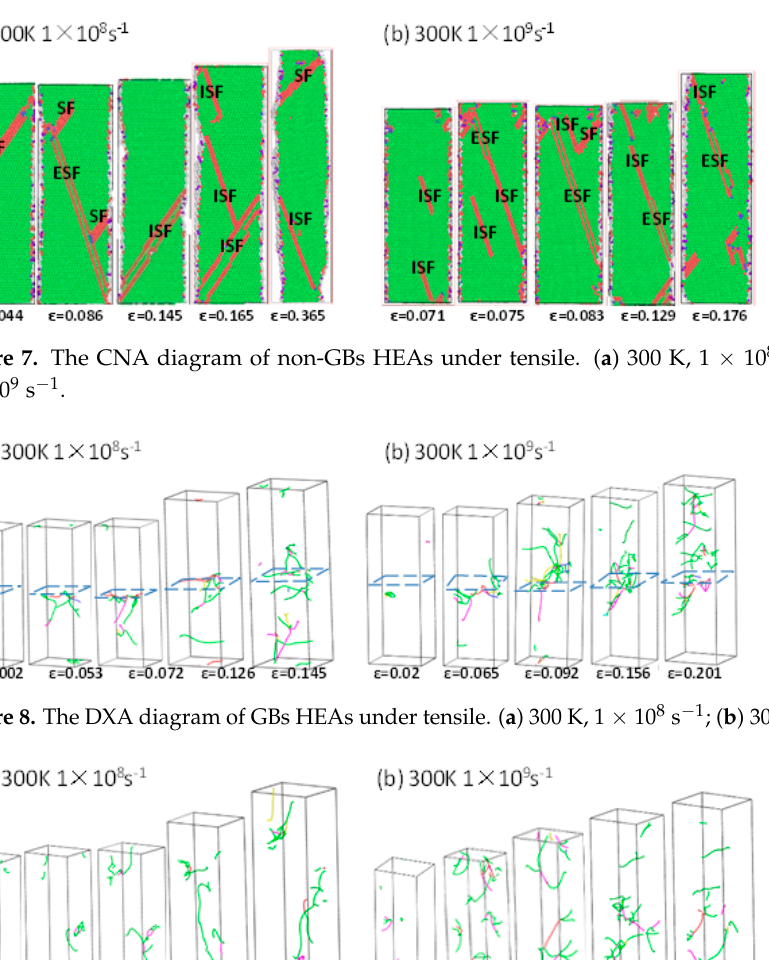
Figure 7. The CNA diagram of non-GBs HEAs under tensile. ( a ) 300 K, 1 × 10 8 s − 1 ; ( b ) 300 K, 1 × 10 9 s − 1 .